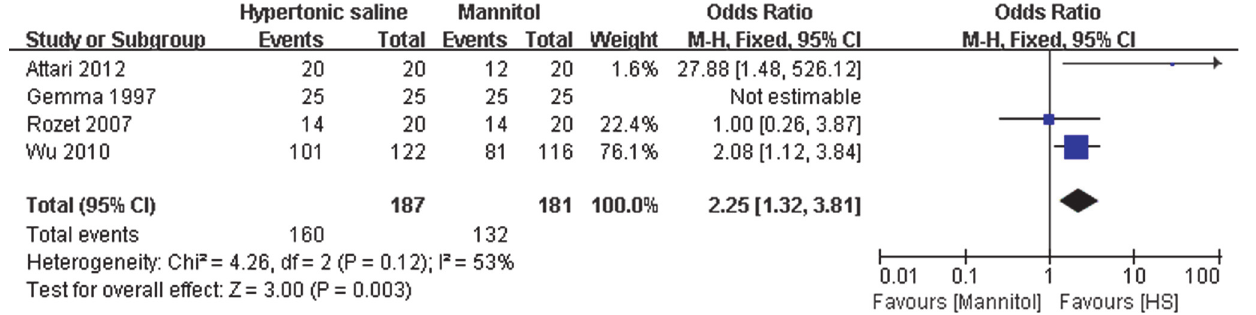
PLOS ONE | DOI:10.1371/journal.pone.0117314 January 30,